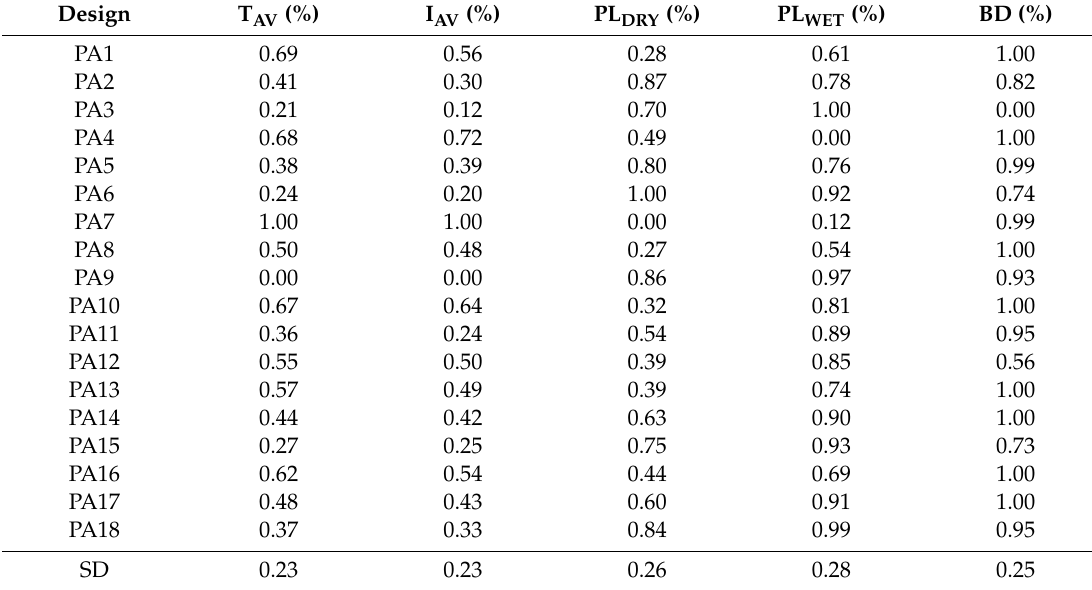
Table 7. Normalized decision matrix according to criteria importance through inter-criteria correlation (CRITIC) methodology.